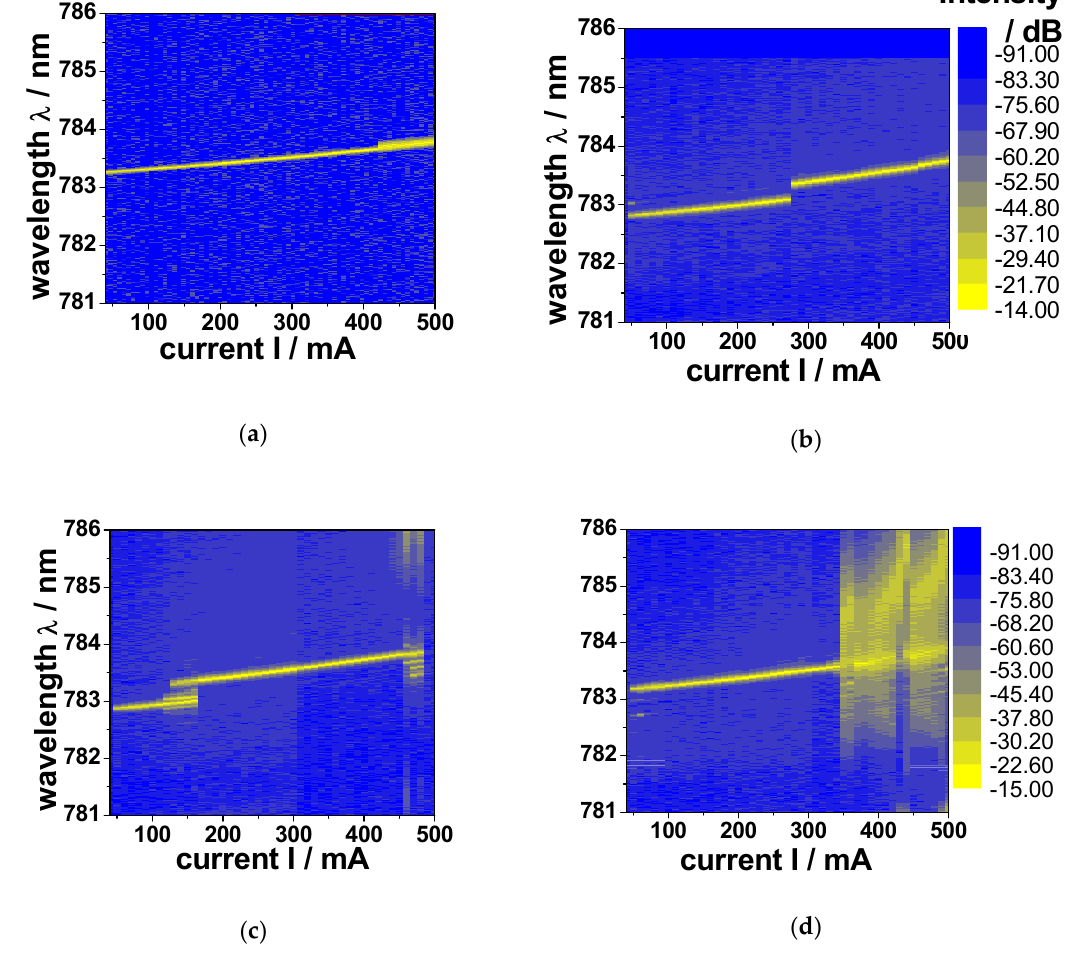
Figure 2. Spectral mappings of 780 nm DFB diode lasers with different front facet reflections: R < 0.01% ( a ), R = 5% ( b ), R = 10% ( c ), and R = 30% ( d ).